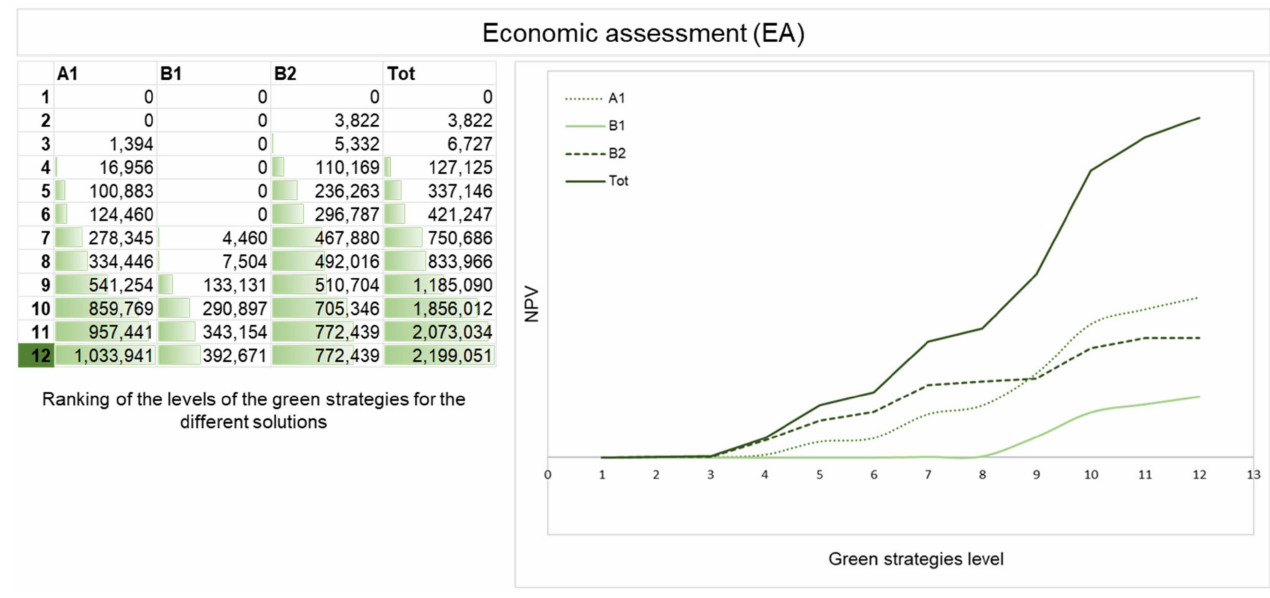
Figure 3. Ranking of interventions for the different levels of green strategy based on the NPV–NPV in the different levels of the green